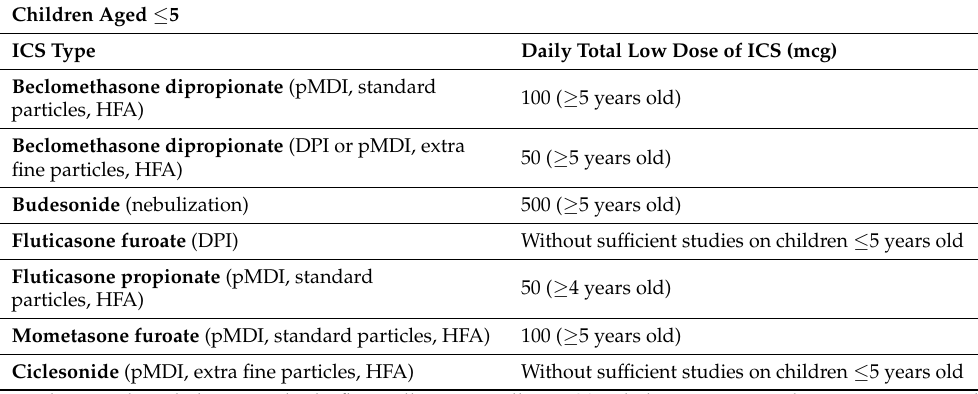
Table 5. Daily total dose of ICS recommended to adolescents aged ≥ 5 for asthma treatment based on GINA 2022